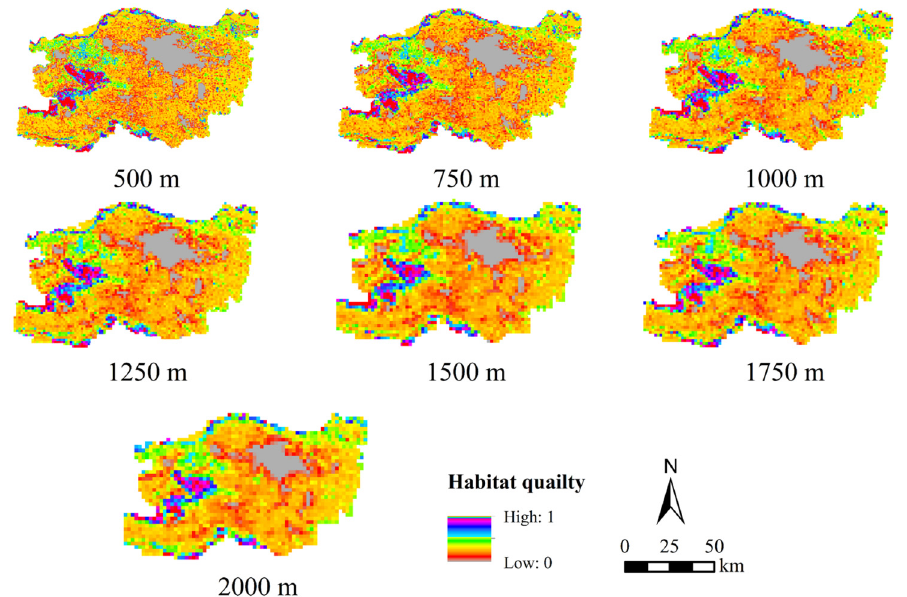
Figure 4. Spatial distribution of the habitat quality in Zhengzhou city at different grid-scales. Table 3. q -value of factors at different